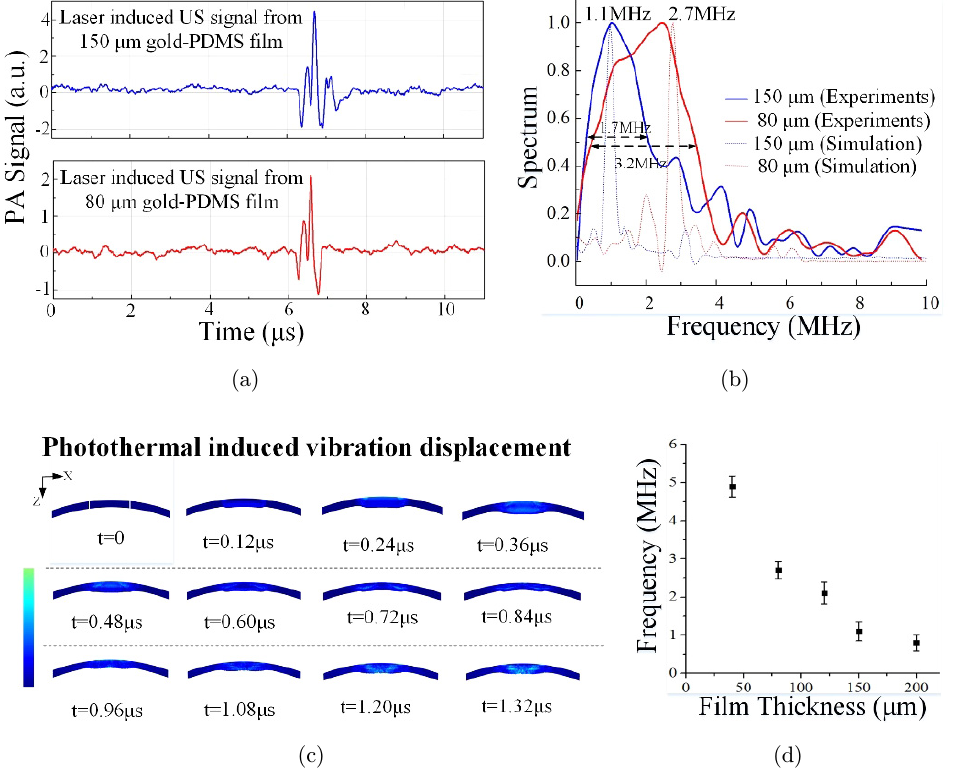
Fig. 4. Experimental and simulated mechanical characterization of the gold-PDMS ¯lms. (a) Experimental results of the detected PA signal of the two ¯lms with di®erent thickness. (b) Spectrum of the experimental and simulated PA signal of two ¯lms with di®erent thickness. (c) Simulated photothermal induced surface displacement of a 150 (cid:1) m gold-PDMS ¯lm. (d) The US wave frequency as a function of the gold-PDMS ¯lm